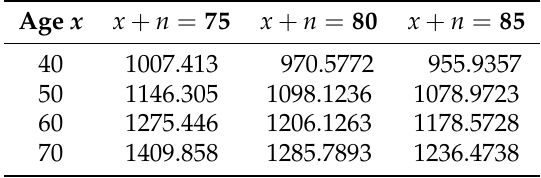
Table 6. Product P3a (Package a); single premium Π